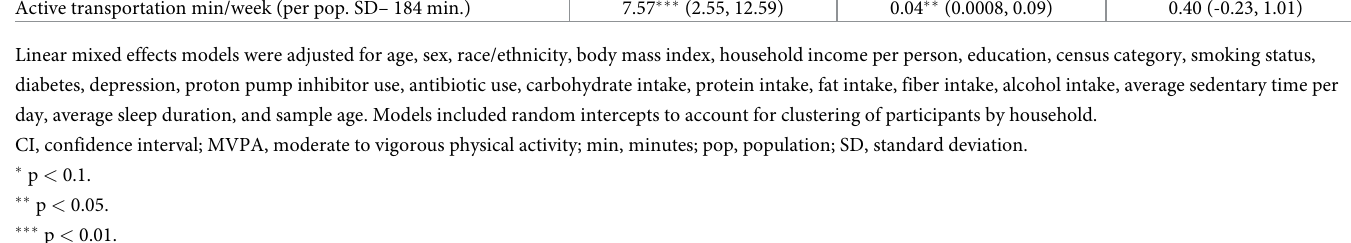
Table 2. Linear mixed effects model estimates of the relationship between physical activity and alpha-diversity. Physical activity measure Chao1 Shannon Inverse Simpson Estimate (95% CI) Estimate (95% CI) Estimate (95% CI) 0.34 (-9.55, 10.23) 0.007 (-0.08, 0.09) 0.38 (-0.84,